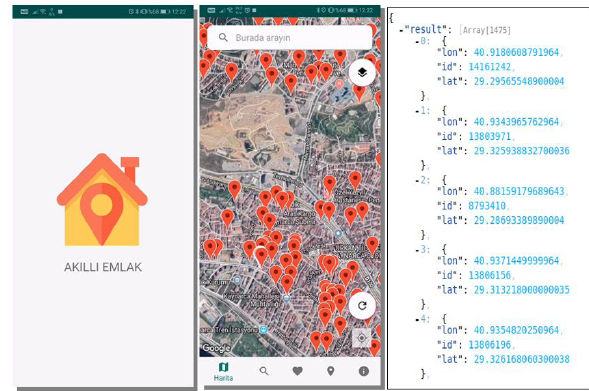
Figure 4. Smart Real Estate mobile app splash screen (left); map screen (mid) and adList Endpoint result JSON data (right)